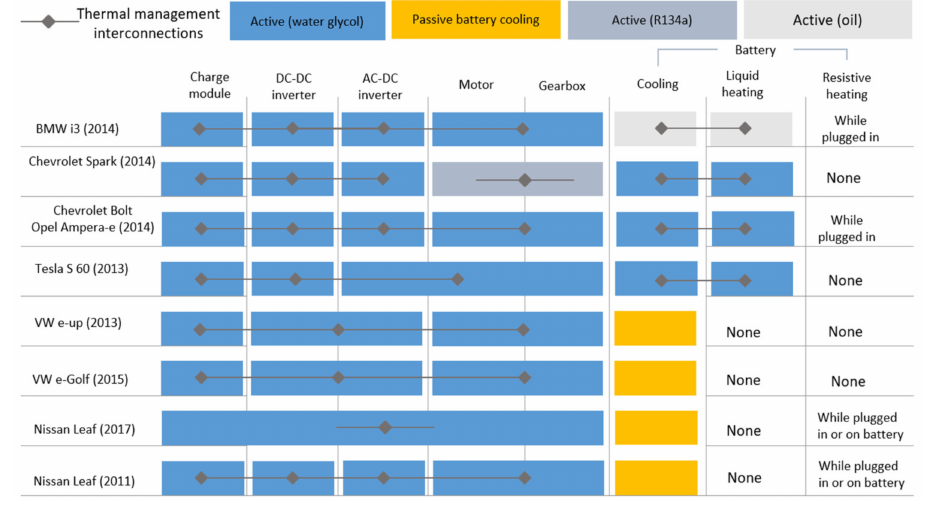
Figure 11. Thermal management systems of selected vehicles (adapted from